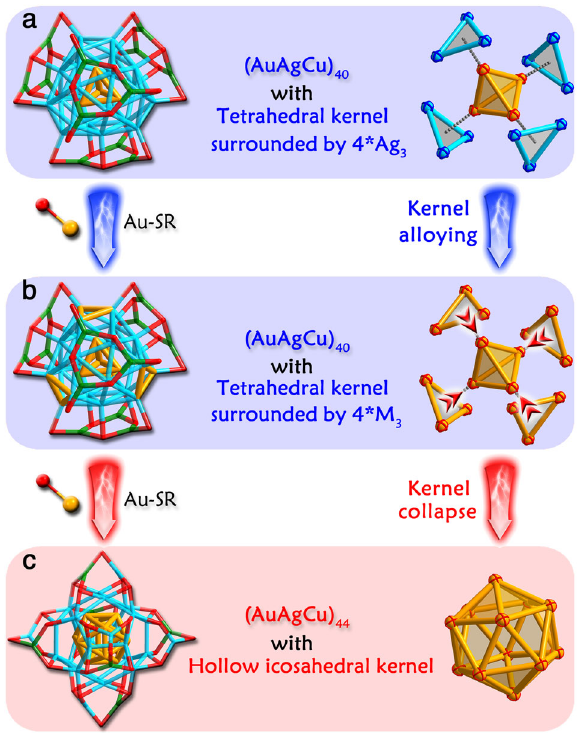
Fig. 3 Kernel transformation from tetrahedron to hollow icosahedron. a Crystal structure of Au x Ag 28- x Cu 12 (SR) 24 ( x = 1.32) and its tetrahedral M 4 (M = Au/Ag) kernel surrounded by four Ag 3 triangles. b Crystal structure of Au x Ag 28- x Cu 12 (SR) 24 ( x = 7.56) and its tetrahedral Au 4 kernel surrounded by four M 3 (M = Au/Ag) triangles. The red arrows represent the trend of kernel collapse from “ tetrahedral Au 4 + 4 ∗ M 3 ” to “ hollow icosahedral Au 12 ” . c Crystal structure of Au 12 Cu y Ag 32- y (SR) 30 ( y = 3.74) and its hollow icosahedral Au 12 kernel. Color labels: light blue, Ag; orange, Au; green, Cu; red, S. All C and H atoms are omitted for